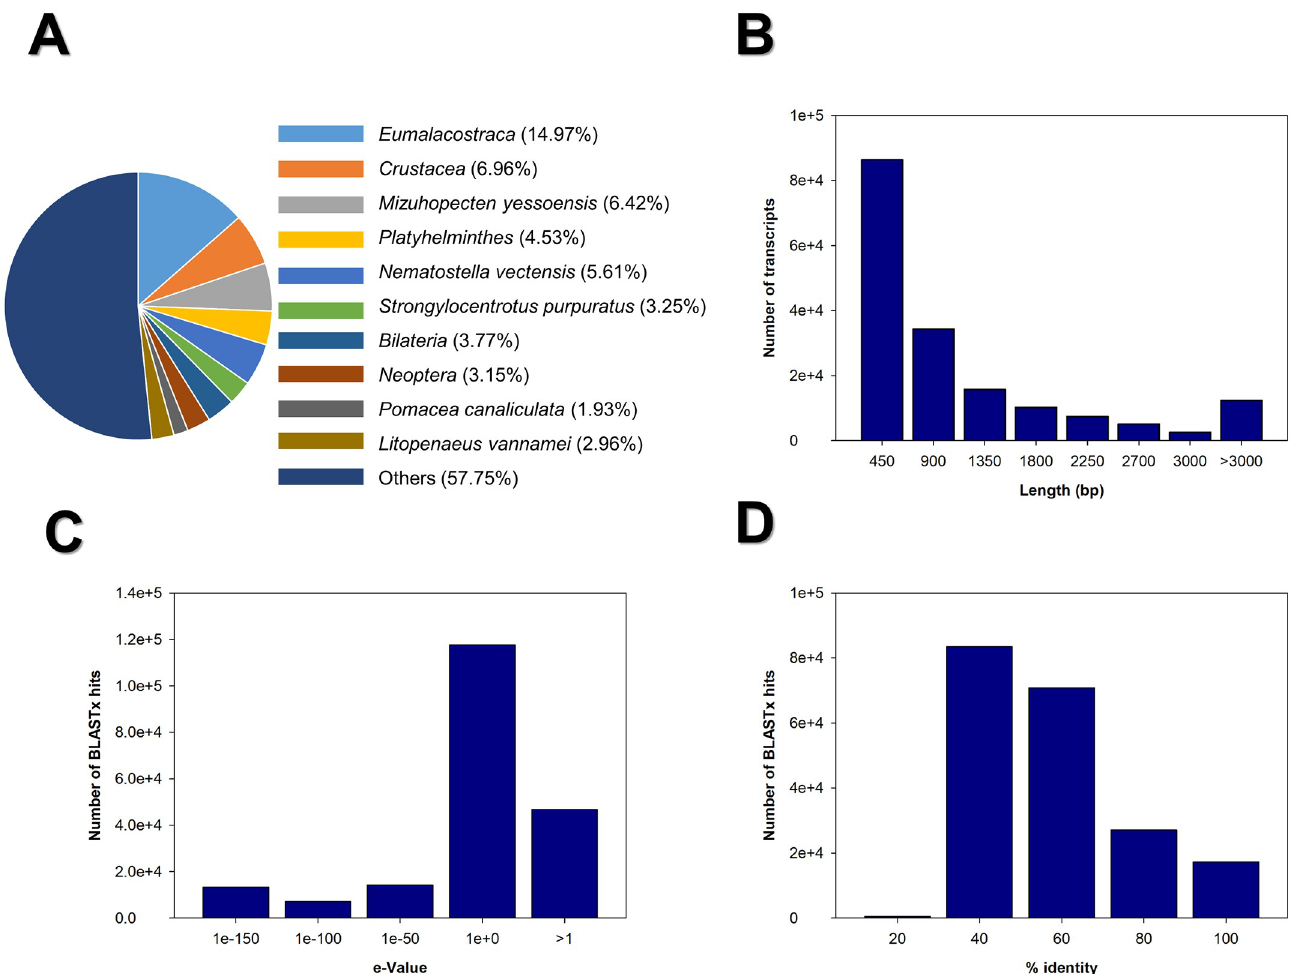
Fig 3. BLASTx statistics, transcript length distribution e- value probability and percentage of transcript identity. RNAseq data was validated using the following parameters: A) Species distribution of the BLASTx using Swissprot and UniProtKB and filtered with the UniProt INV database which includes the invertebrate phyla: Arthropoda, Mollusca, Porifera, Cnidaria, Echinodermata, Platyhelminthes, Nematoda and Annelida. B) Transcript length distribution after trinity assembly. In the X- axis the total transcript set was grouped into different lengths (shown in base pairs, bp), the Y- axis shows the frequency of each transcript group. C) An e-value was calculated (X- axis) to determine the number of random hits in our BLASTx (Y- axis). D) Percentage of identity (in the X- axis) was also calculated after the BLASTx, shown in the Y- axis as number of BLASTx hits.